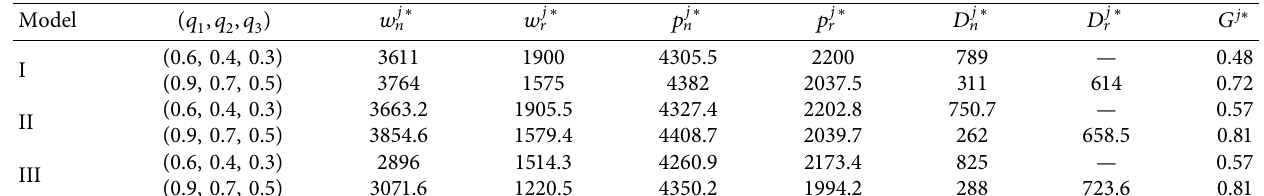
i in the three models.